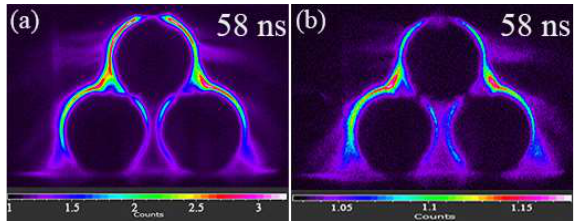
Figure 9. ICCD images of the final discharge morphology during the pulse rising time in nitrogen ( a ) without a filter and ( b ) with a filter.